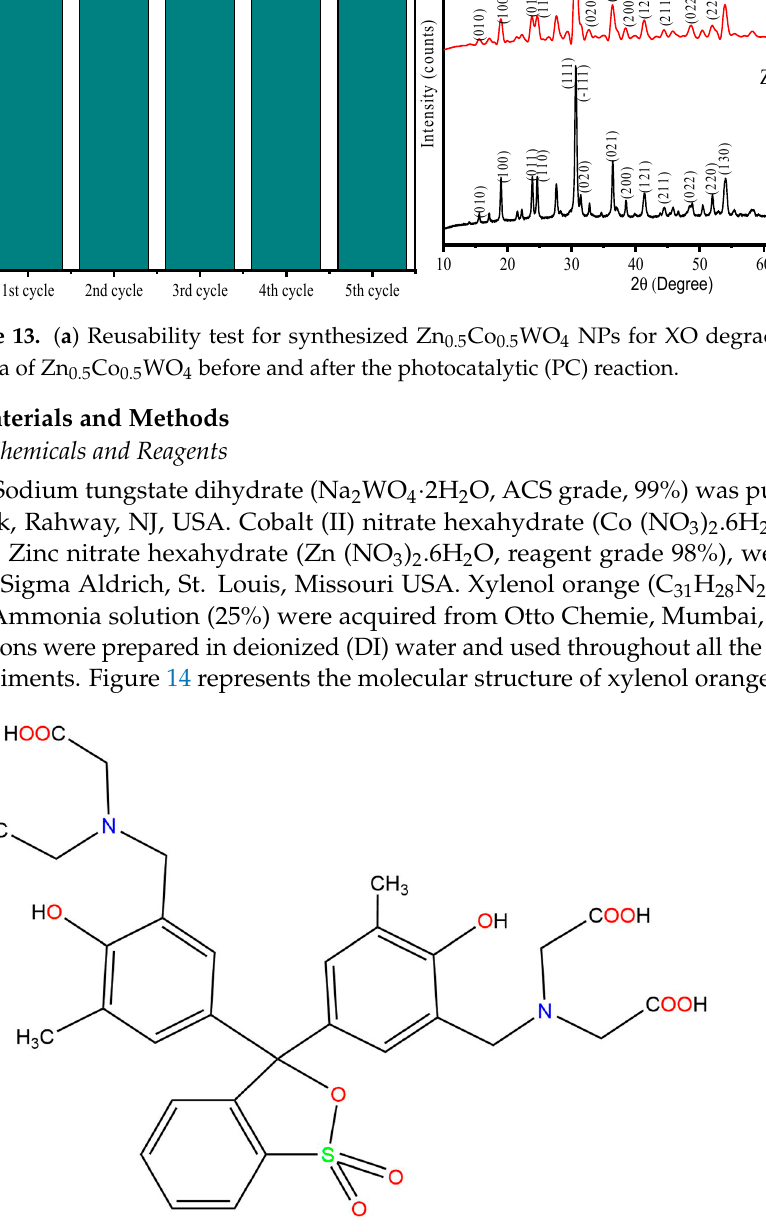
Figure 14. Structure of xylenol orange